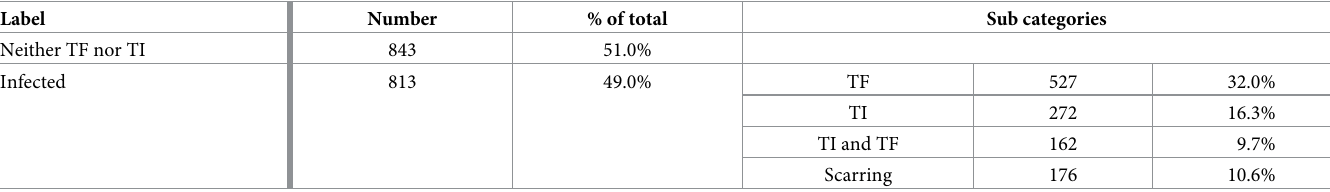
Table 1. Distribution of clinical categories in our